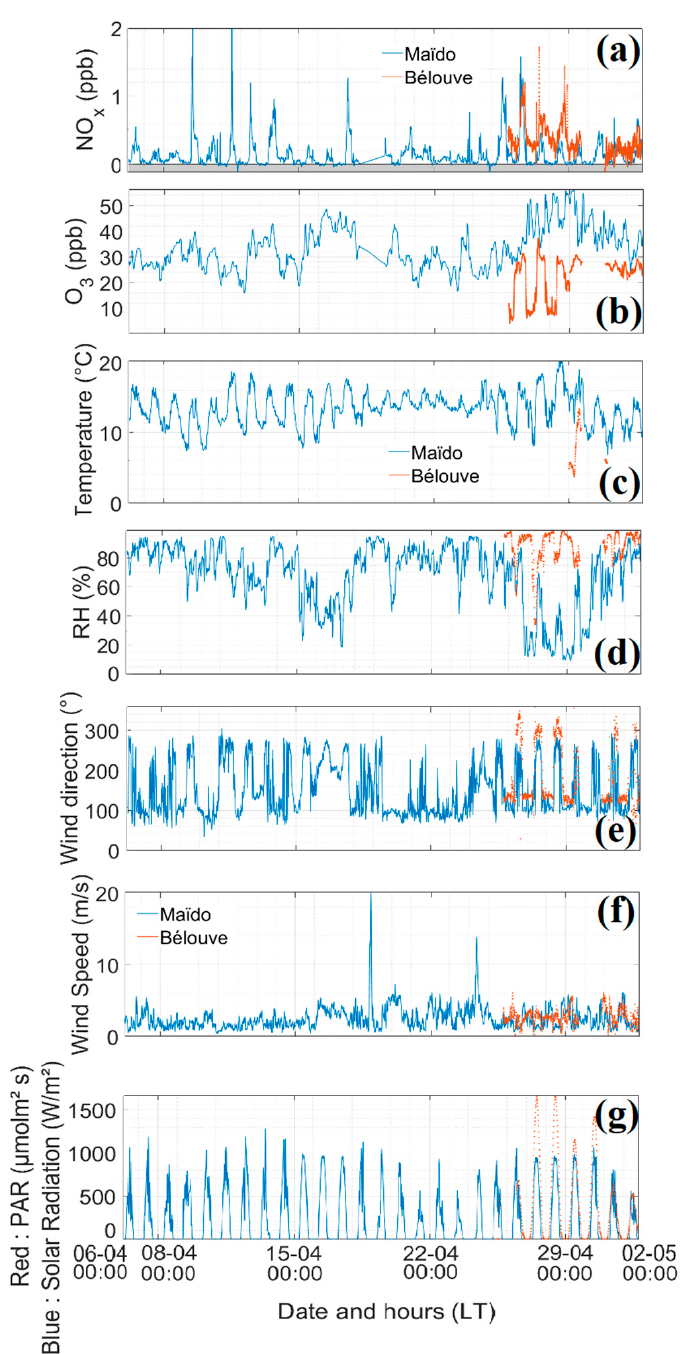
Figure 4. Time series of gases (NO x and O 3 ), temperature, relative humidity, wind speed and direction and solar radiation parameters from 6 April to 2 May 2018. Blue, Maïdo; orange, Bélouve; LT, local time. ( a ) Nitrogen oxides (NO x , ppb), ( b ) ozone (O 3 , ppb), ( c ) Temperature (°C), ( d ) Relative Humidity (RH, %), ( e ) Wind Direction (°), ( f ) Wind Speed (m s − 1 ), ( g ) Red : PAR (µmol m − ² s − 1 ), Blue : Solar radiation (W m − ²).